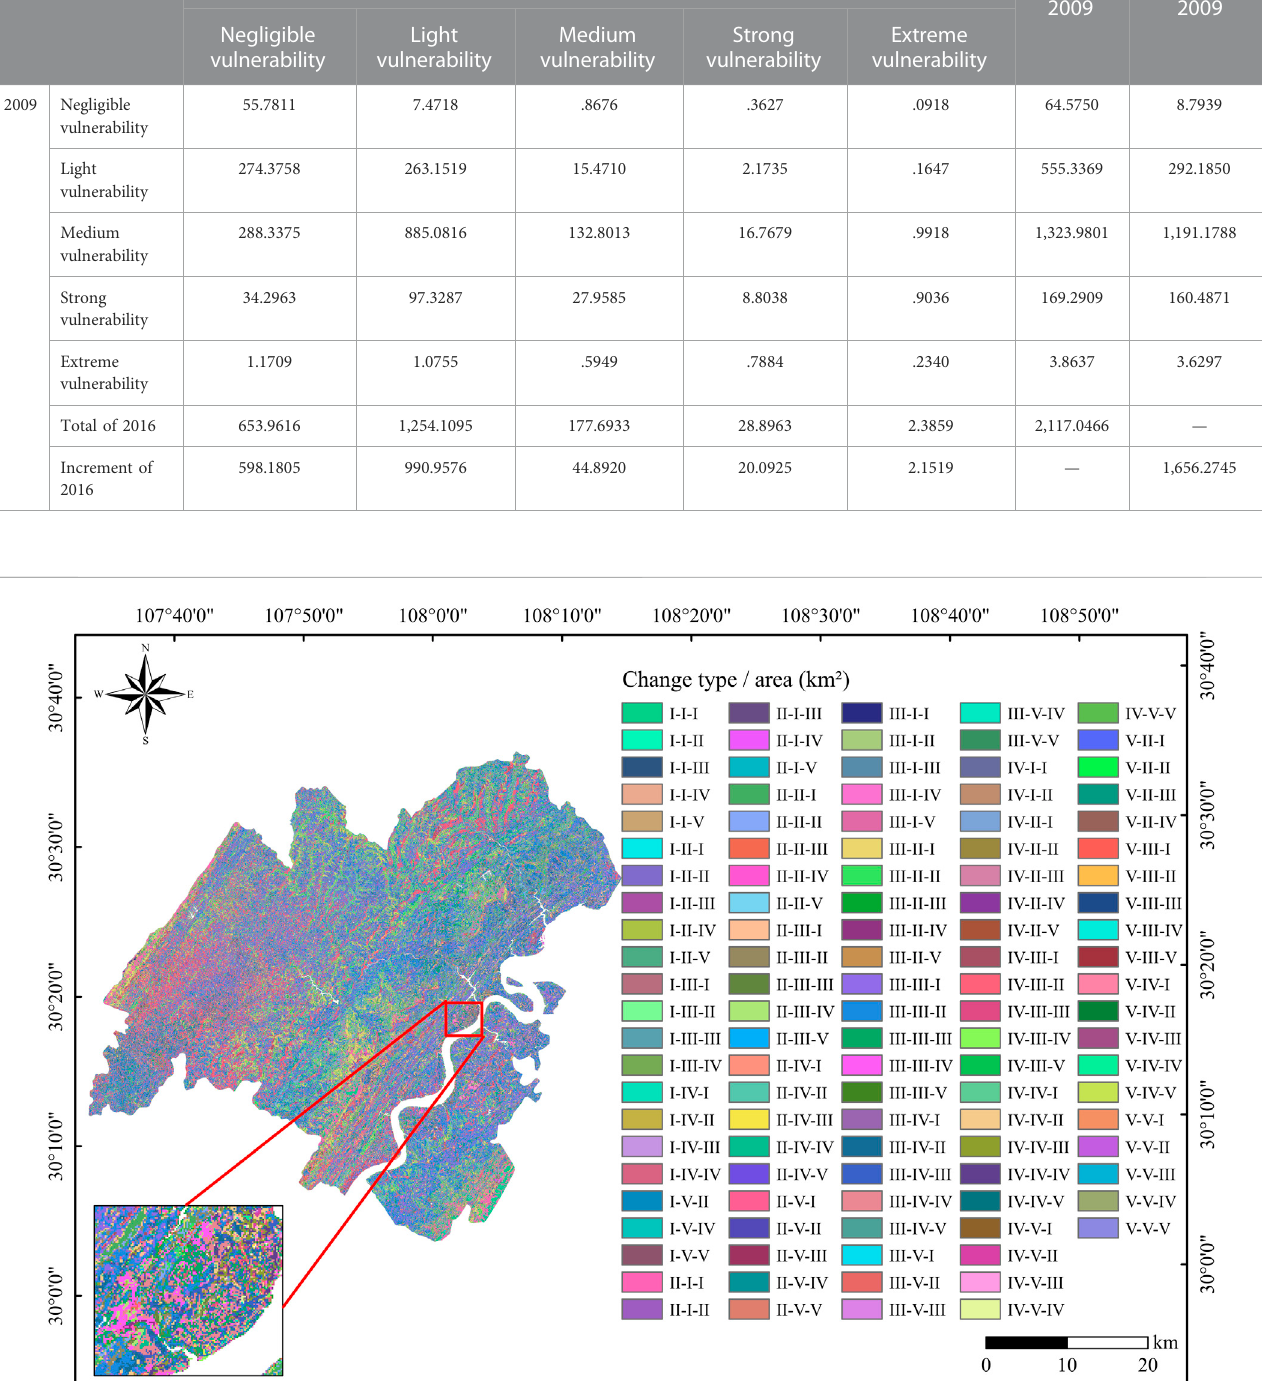
Frontiers in Environmental